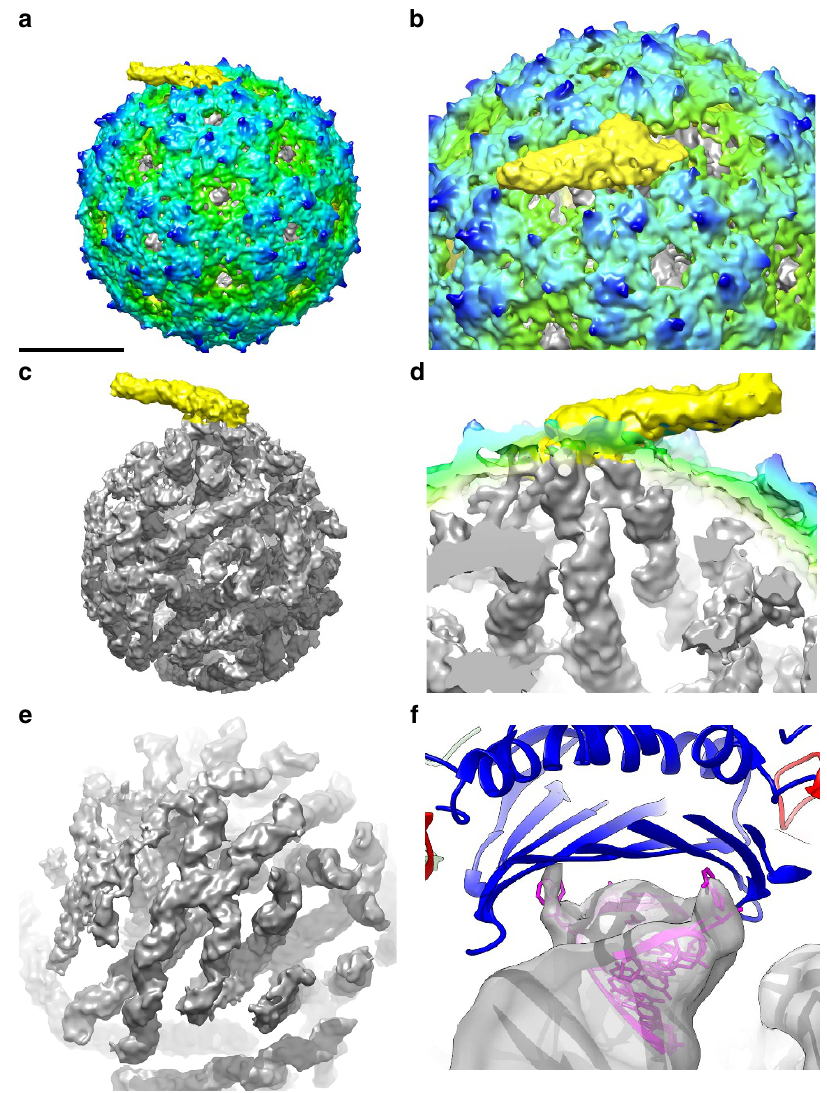
Figure 1 | The asymmetric reconstruction of bacteriophage MS2. Asymmetric structure of bacteriophage MS2 (green–blue radially coloured) shows the AP (yellow) ( a ), which replaces one CP dimer ( b ). Inside the protein capsid a structured genome (grey) is present ( c ) that is connected to the AP ( d ). The reconstruction shows the double-stranded helices in the stem loop structures ( e ). At some positions individual NA’s connecting to the capsid are resolved, as shown by fitting of the X-ray structure of the 19-nucleotide TR (magenta) bound to the capsid (blue) (pdb:1ZDH) in the EM density (grey) ( f ). Scale bar is